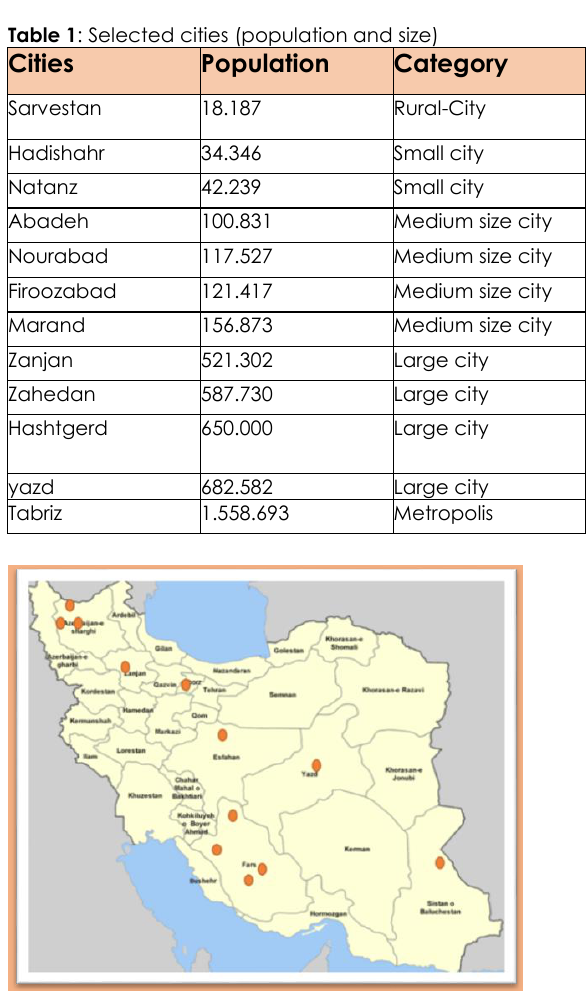
Figure 1 : Selected cities on the map of